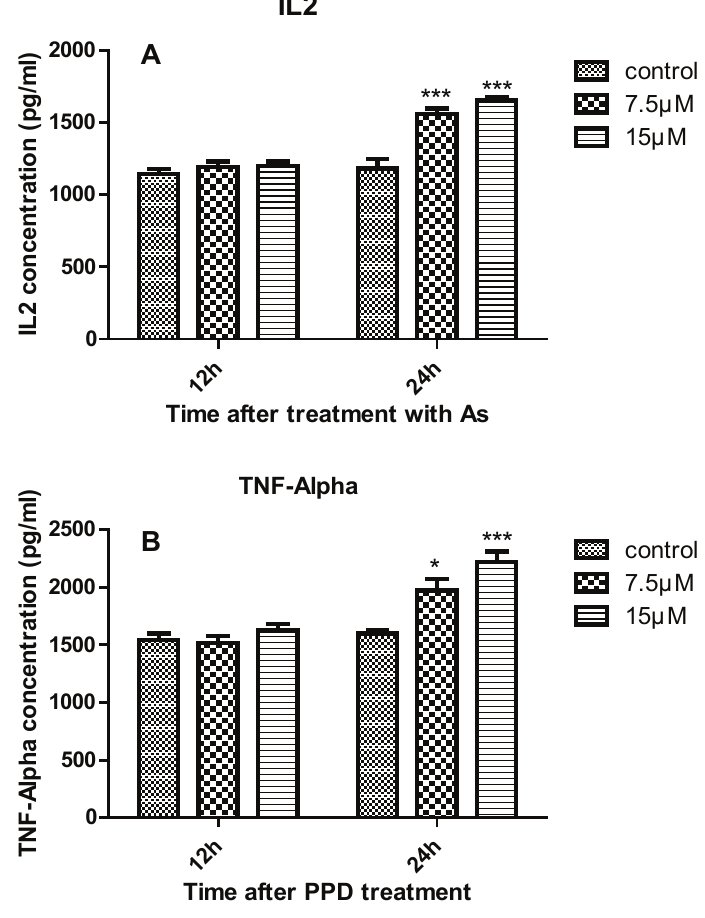
Figure 8: The effect of As on production of cytokines following 12 and 24 h treatment. Statistically significant (P < 0.05) increase in production of cytokines was observed with IC and 1/2 IC concentration of As (15 and 7.5 µM) at 6 h time interval (a: IL2; b: TNF-alpha). 50 50 * (P < 0.05) and (*** P < 0.001): significant difference compared to the control